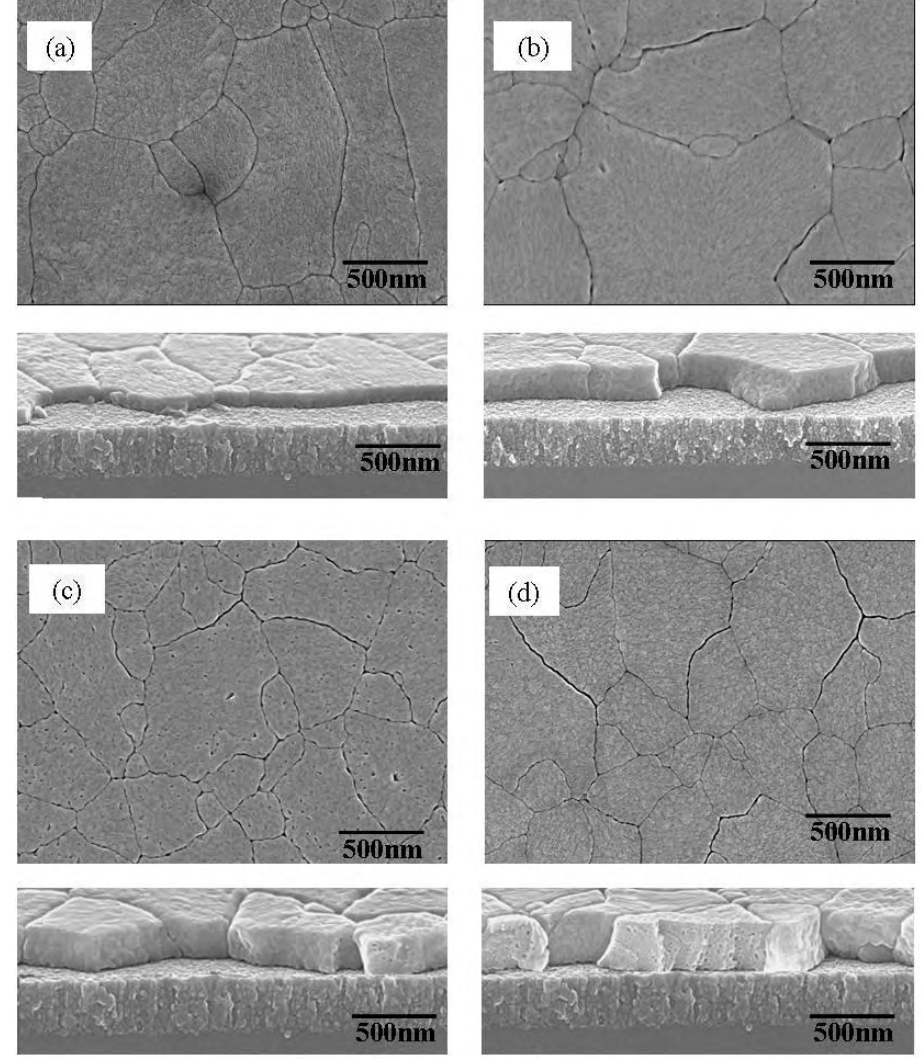
Figure 5. SEM micrographs of surface morphology and cross section of WO (b) 120 (c) 150 (d) 200nm thicknesses after